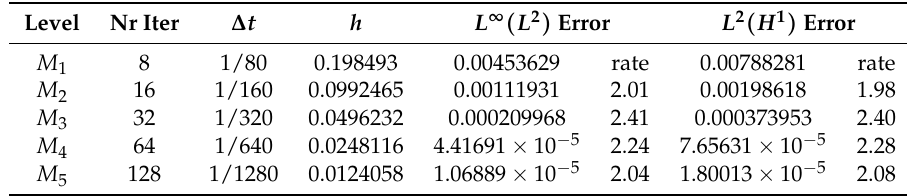
Table 4. L ∞ ( L 2 ) and L 2 ( H 1 ) errors and rates for the modified Leray-deconvolution model with N = 1. The final time is T = 0.1. The predicted rate order is